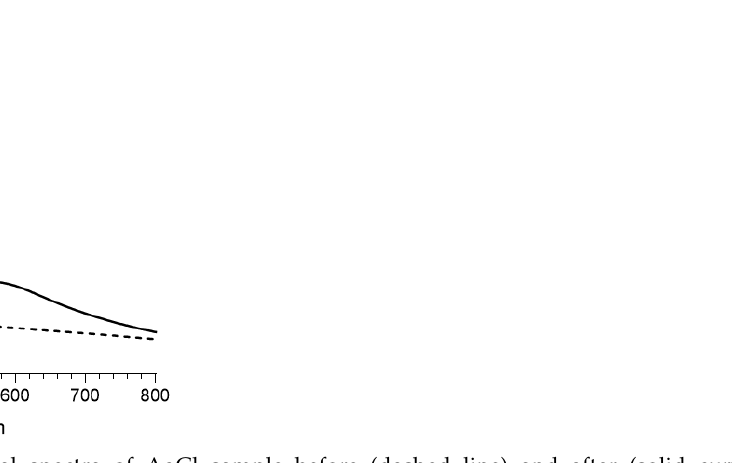
Figure 2. The optical spectra of AgCl sample before (dashed line) and after (solid curve) sunlight irradiation.